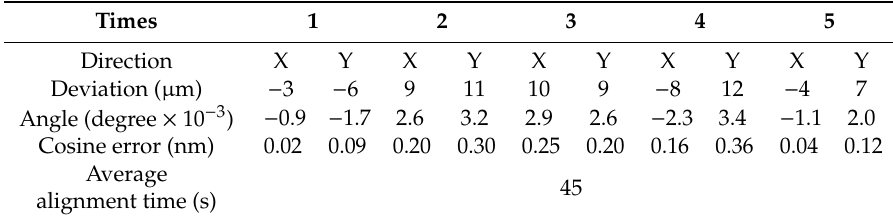
Table 2. Results of fine alignment.